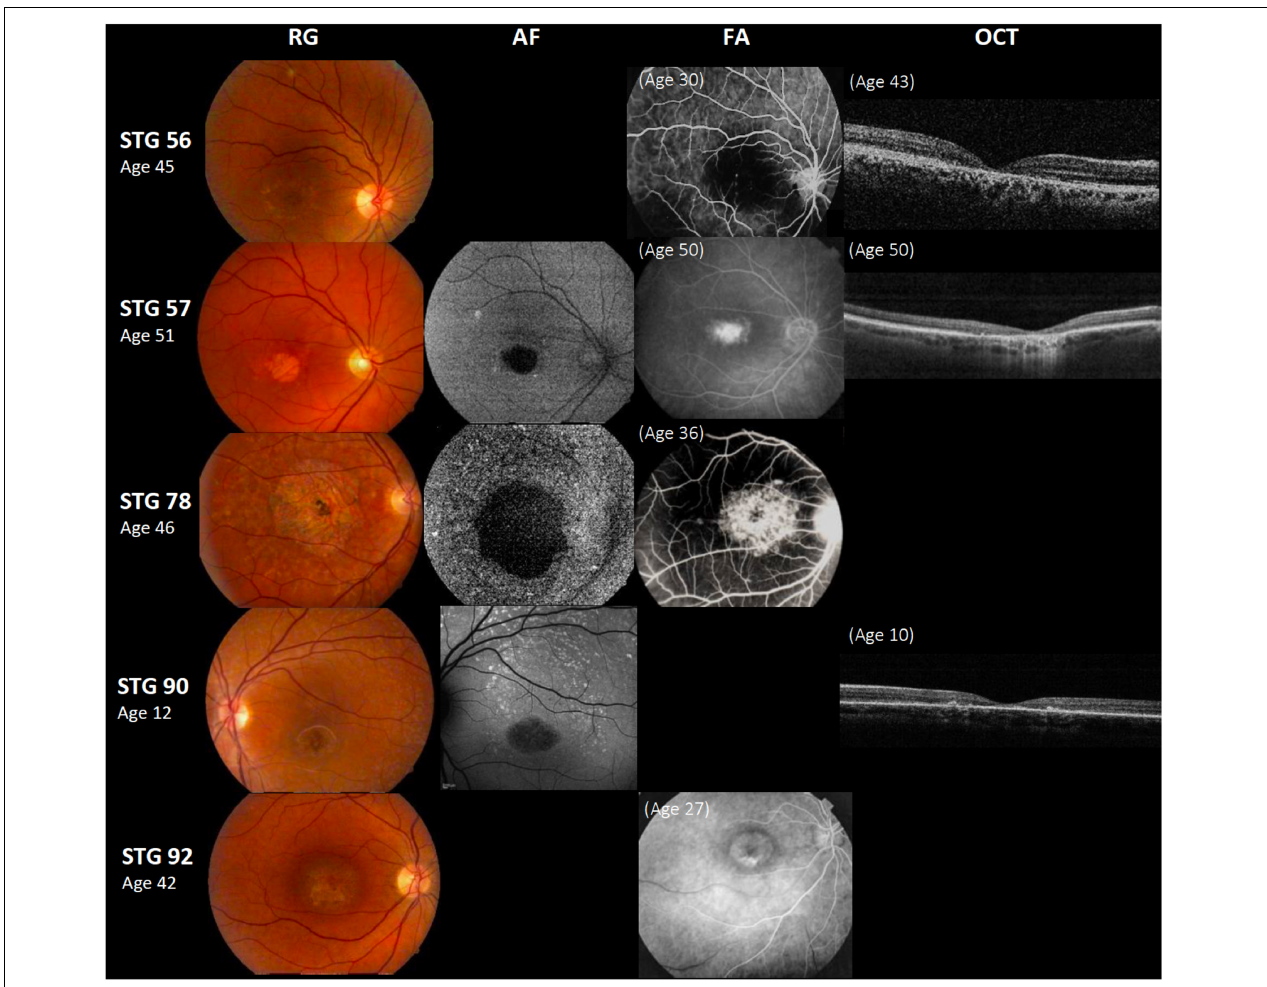
FIGURE 1 | Clinical presentation in patients harboring a single ABCA4 variant. Patients STG 56, STG 57, STG 78, and STG 90 show central atrophy surrounded by macular and peripheral flecks (fundus grade: 3b), which are more visible on AF image of STG 78 and STG 90, showing widespread multiple foci of high and low AF signal with heterogeneous background (AF type 2). These patients demonstrate dark “silent” choroid on Fluorescein angiography images (FA) and macular hyperfluorescence consequence of retinal pigment epithelium and photoreceptors loss. Patient STG 92 present on FA image at the age of 27 years-old, hyperfluorescent annular lesion showing perifoveal atrophy without flecks (Bull’s eye maculopathy) according to fundus grade 3a, further in the course of the disease with 42 years-old, note an enlargement of macular atrophy on color fundus photograph (RG). The optical coherence tomographic images (OCT) present decreased retinal thickness with disruption of external